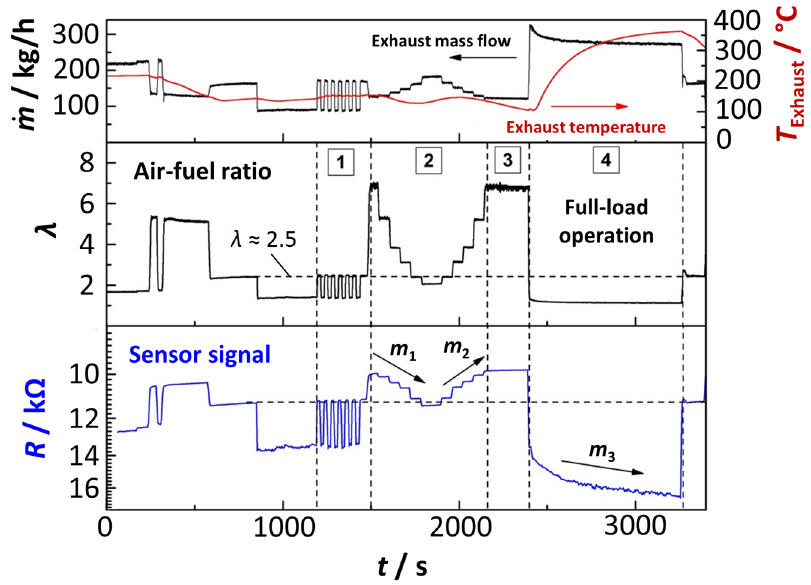
. m and temperature T Exhaust ; Center: